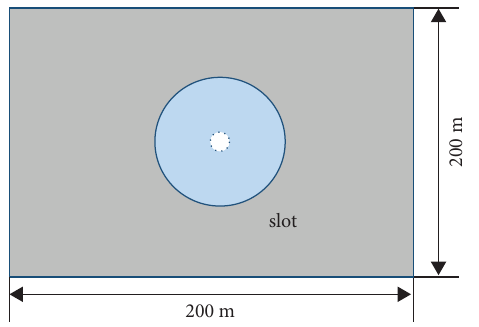
Figure 4: Joint numerical model of coal seam cutting pressure.